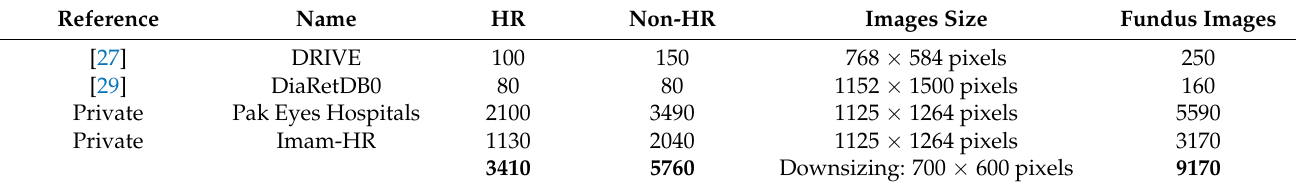
Table 2. Image data of the retina for the Mobile-HR system.